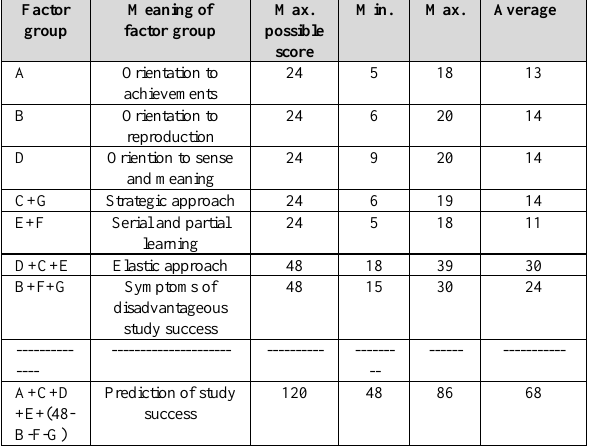
Table 2: The results of the